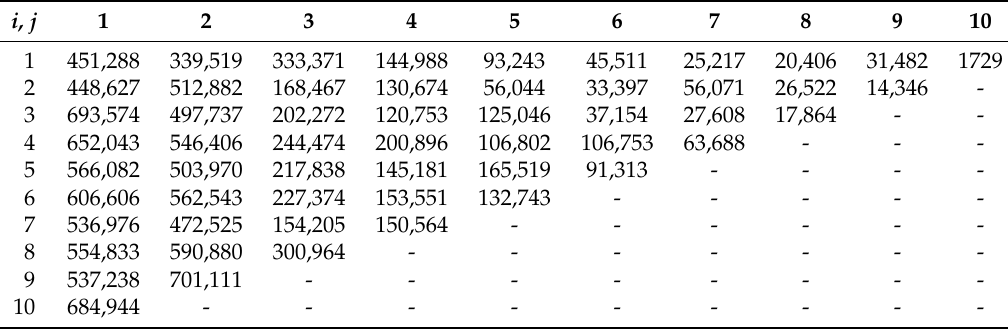
Table A1. Insurance run-off triangle taken from Verrall et al. (2010, Table 1) as used in the empirical application in Section 5.1 and the simulations in Section